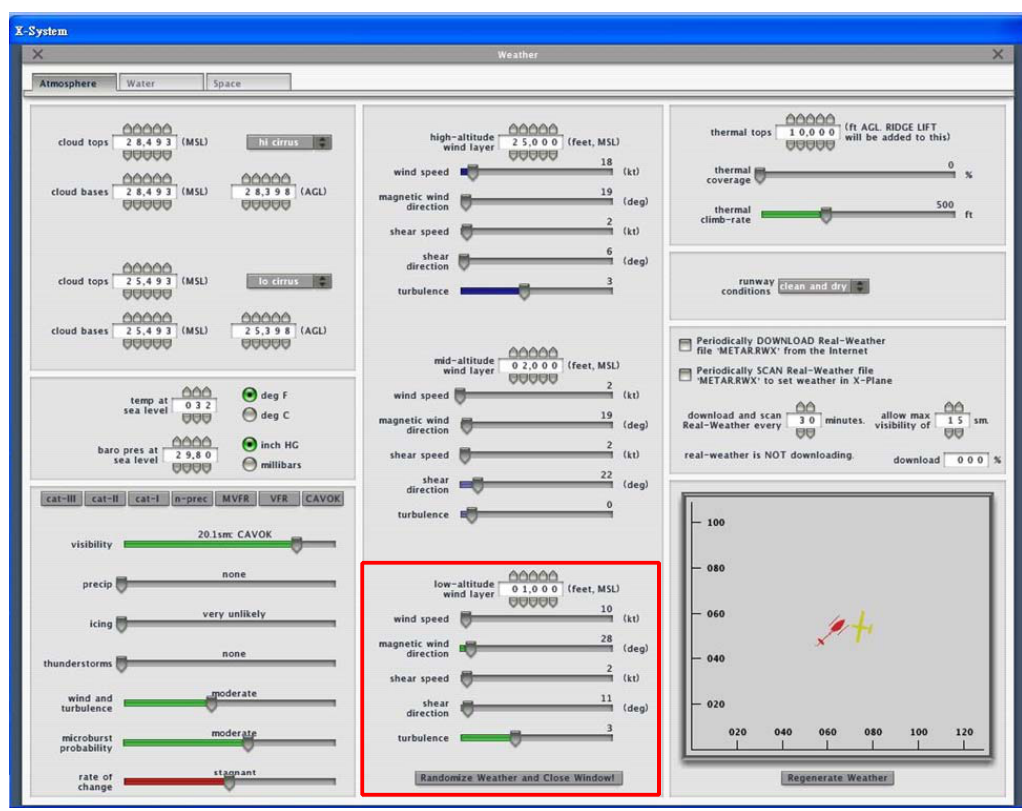
Figure 14. Stable weather settings.